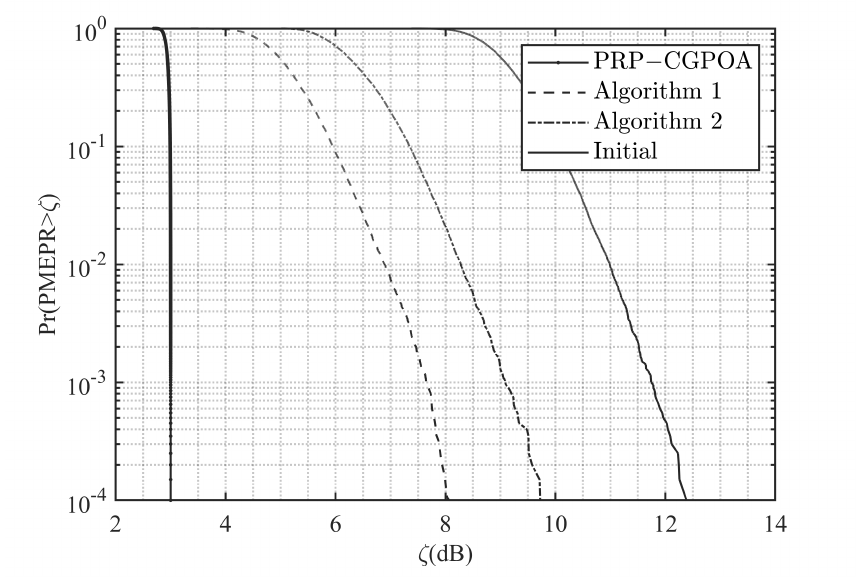
Figure 5. PMEPR reduction comparison for three algorithms, where Algorithm 1 is from [19] and Algorithm 2 is from [28].